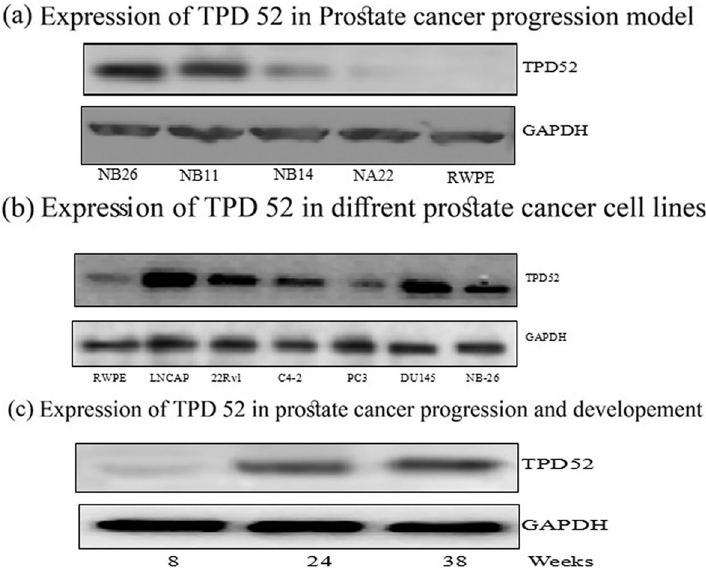
Figure 4. Expression of TPD52 in prostate cancer. ( a ) Expression of TPD52 in prostate cancer progression model. RWPE < WPE2-NA22 < WPE1-NB14 < WPE1-NB11 < WPE1-NB26 with increase in proliferation and progression of cancer protein expression of TPD52 also increased as depicted by Immunoblot analysis. The total cell lysate was prepared and 40 μg protein was subjected to SDS-page followed by Immunoblot analysis and chemiluminescence detection. ( b ) Expression of TPD52 was observed in seven prostate cancer cell lines (RWPE, LnCap, Du145, CWR22Rν1, PC3, C 4-2, and NB26) under regular culture conditions. Except for RWPE-1 all other cell lines tested showed marked protein expression of TPD52 in Immunoblot analysis. ( c ) Immunoblot analysis for expression of TPD52 in prostate cancer development and progression model (transgenic adenocarcinoma of the mouse prostate, TRAMP), showed an increase in expression with the development and progression of prostate cancer. The blots shown here are representative of three independent experiments with similar